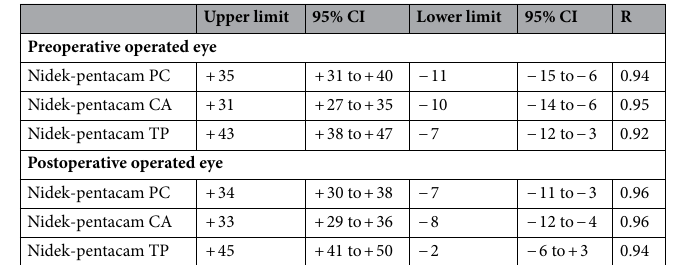
Table 3. 95% Limits of agreement (LoA) preoperative and postoperative operated eye. PC pupil center, CA corneal apex, TP thinnest point, R Pearson correlation coefficient.